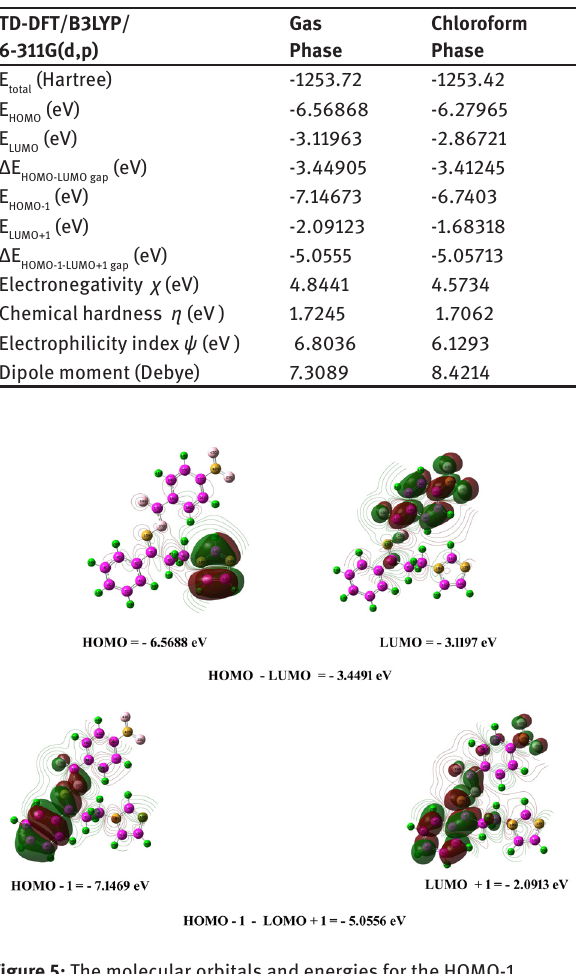
at 6-311G(d,p) level. The 3D plots of the HOMO-1, HOMO, LUMO and LUMO+1 orbitals computed at the B3LYP/6- 311G(d,p) level for the IPAONM molecule are illustrated in Figure 5. The positive phase is red and the negative one is green. It is clear from Figure 5 that while the HOMO is localized on the imidazole moiety of the IPAONM molecule, the LUMO is localized on the nitrophenyl ring. However, the HOMO-1 is localized on the other phenyl ring, LUMO+1 is localized on both phenyl ring and the nitro group of the title molecule. Both the HOMOs and the LUMOs are mostly π-antibonding type orbitals.